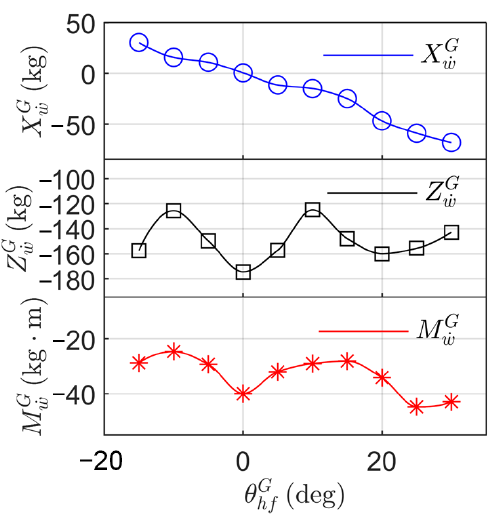
Figure 14. The results of w dependent added mass coefficients. In the pure pitch simulation, the submerged glider moving forward at a specified velocity ( u 0 = 1 m/s) is sinusoidally oscillated in the z-direction and its x-axis is always tangential to the sinusoidal path, which is shown in Figure 15.